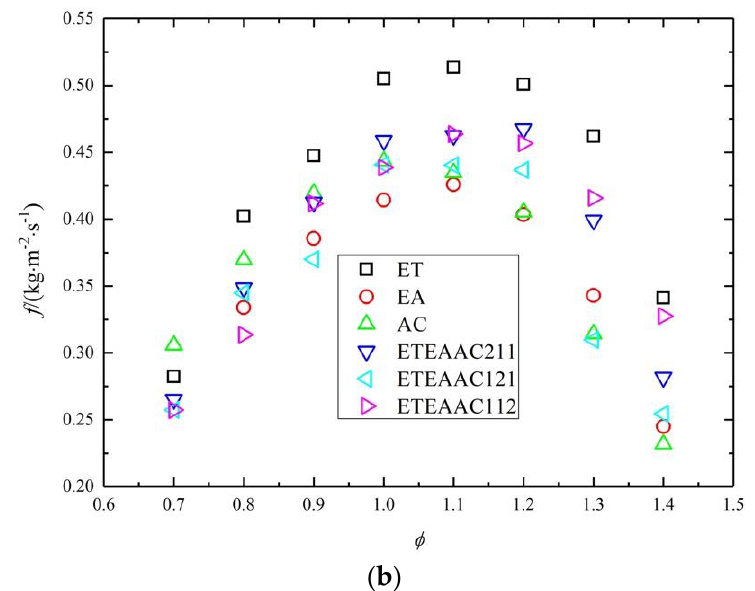
Figure 6. Laminar burning flux of the mixed fuels at T 0 = 358 K, P 0 = 1 bar, and ϕ = 0.7 – 1.4. ( a ) The laminar burning flux of ET/EA/AC/ETEAAC122/ETEAAC212/ETEAAC221, ( b ) The laminar burning flux of ET/EA/AC/ETEAAC211/ETEAAC121/ETEAAC112.